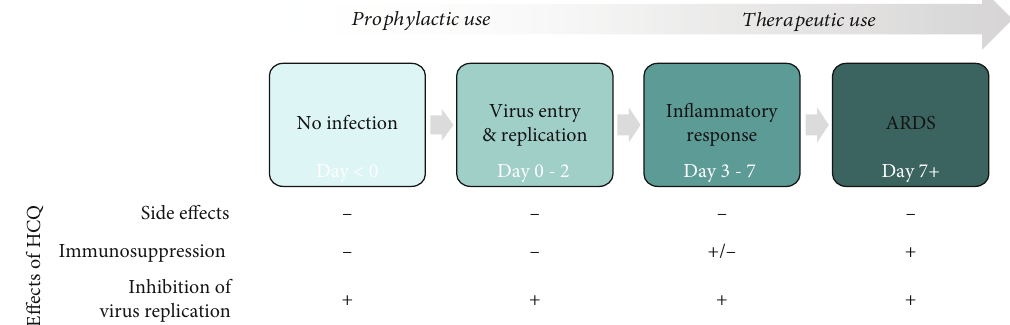
Figure 3: Theoretical e ff ects of HCQ at di ff erent stages of SARS-CoV-2 infection. Potential HCQ e ff ects on COVID-19 are schematically presented over the course of the disease, ranging from prophylactic use in uninfected subjects to therapeutic use in acute respiratory distress syndrome (ARDS) in severe patients. A bene fi cial HCQ e ff ect is indicated with “ + ” and a detrimental HCQ e ff ect with “ -. ” The stages of SARS-CoV-2 infection are indicated in green. Stage 0 — no infection, stage 1 — virus entry and replication in the airway cells, stage 2 — activation of innate and adaptive immune system, and stage 3 —